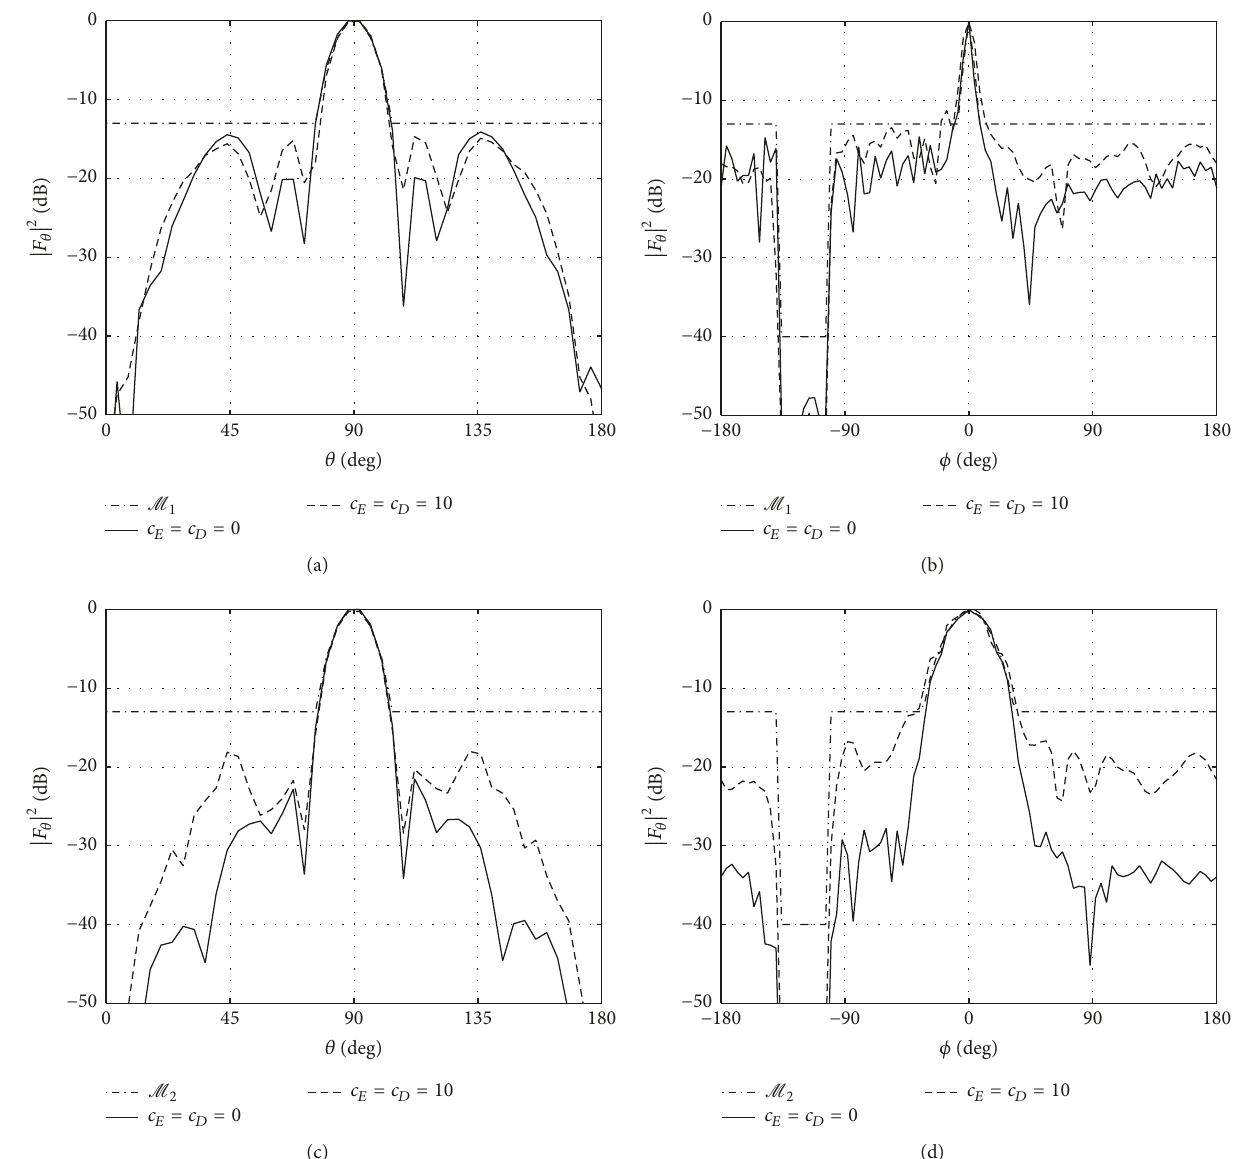
Figure 5: Second application, 2D far-field pattern cuts: (a) 𝑙 = 1 (first pattern), cut at 𝜙 = 0 ∘ , (b) 𝑙 = 1 (first pattern), cut at 𝜃 = 88 ∘ , (c) 𝑙 = 2 (second pattern), cut at 𝜙 = 0 ∘ , and (d) 𝑙 = 2 (second pattern), cut at 𝜃 = 88 ∘ .